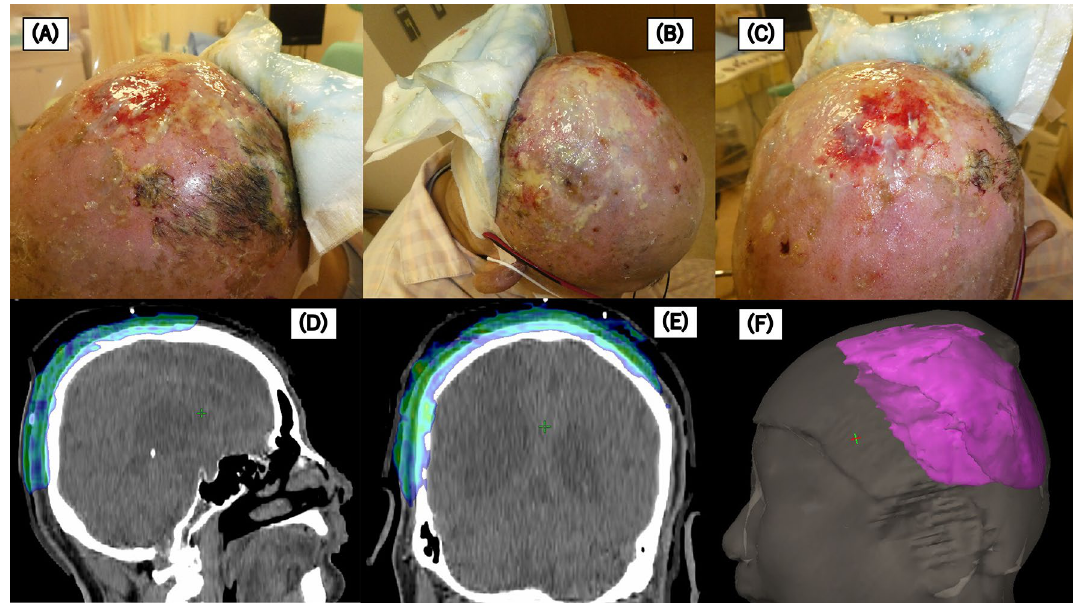
Figure 1. A case of a patient with severe dermatitis and the dose distribution. In figure ( D , E ), the region where 100% dose of the prescribed dose was irradiated is shown by dose-color-wash. In figure ( F ), the region where 100% dose of the prescribed dose was irradiated is displayed in three